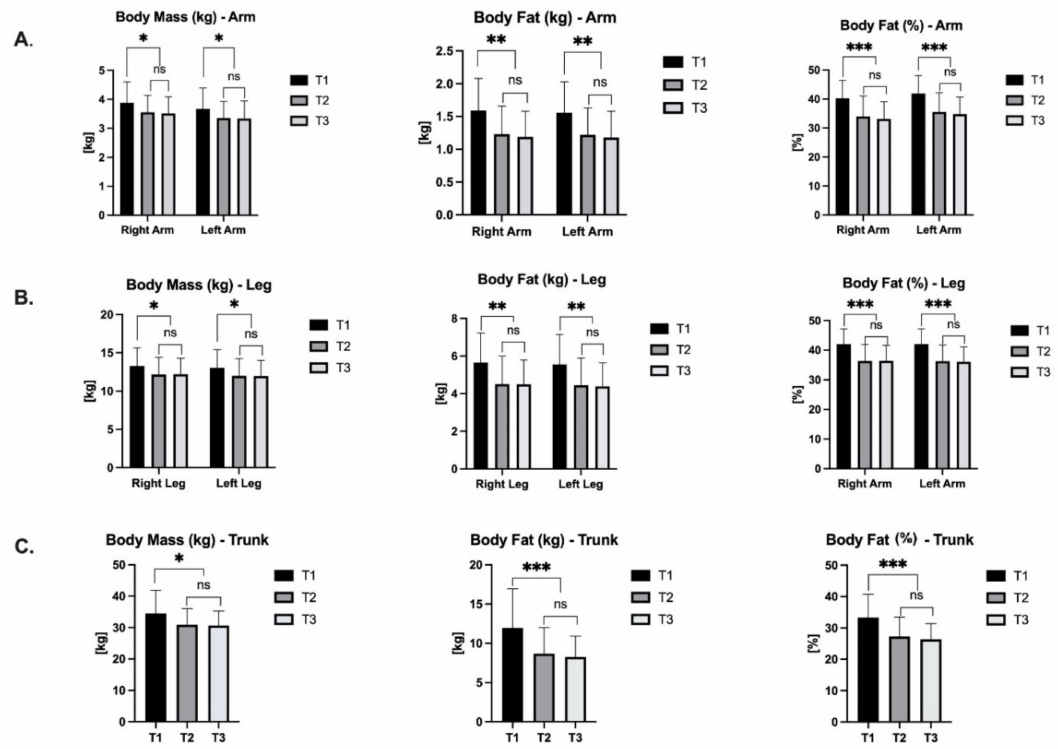
Figure 1. Mean values of segmental body mass and body fat distribution in the monitored women. ( A ) Distribution of BM and BF in upper limbs, ( B ) Distribution of BM and BF in lower limbs, ( C ) Distribution of BM and BF in the trunk. ns not significant, * p < 0.05, ** p < 0.01, *** p <